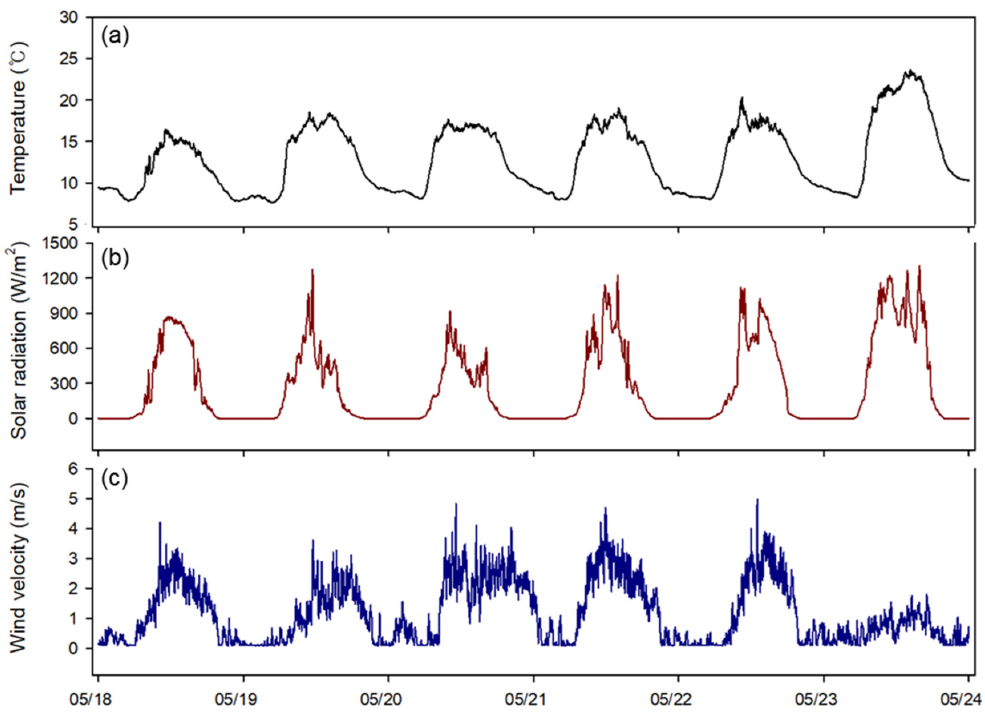
Figure 12. Changes in outside environmental conditions in the experiment: outside temperature ( a ), solar radiation ( b ), and wind velocity ( c ).